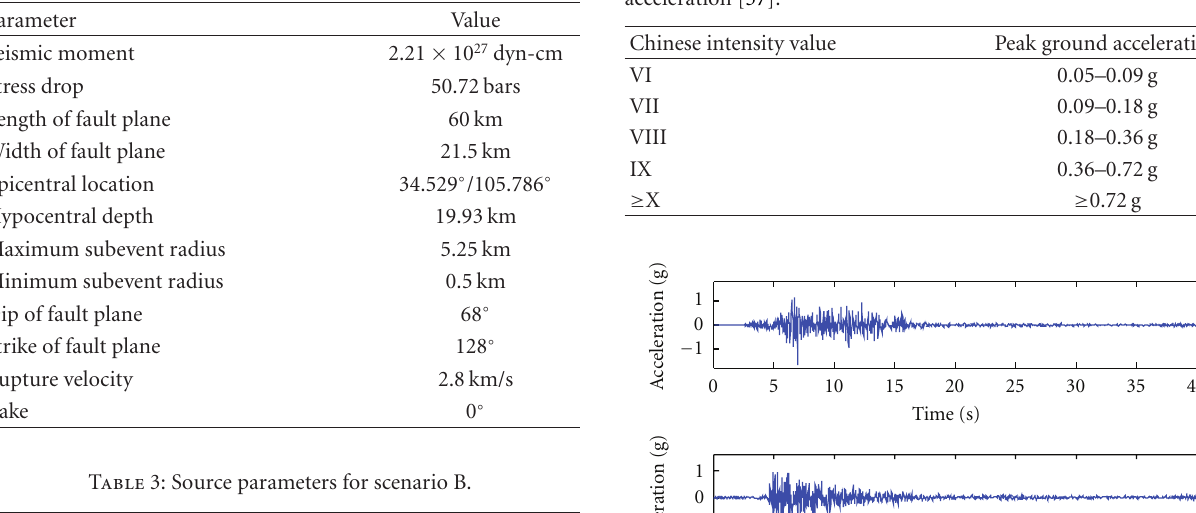
Table 2: Source parameters for scenario A.